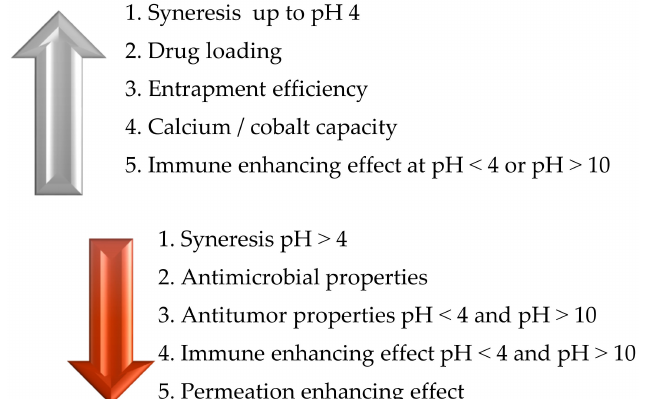
Figure 3. Influence of pH on the biological and physicochemical characteristics of chitosan.